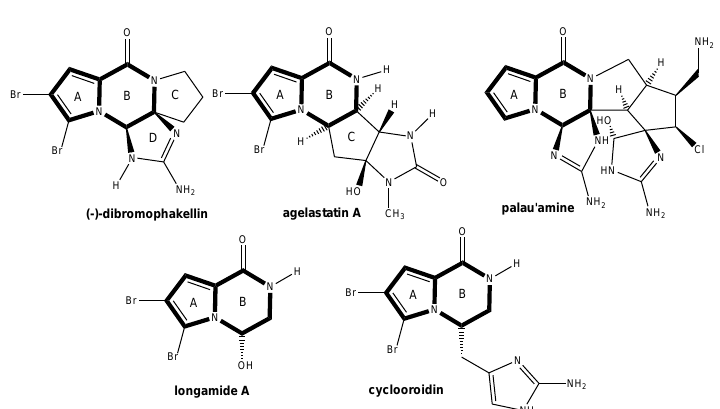
Figure 1. Example of pyrrole-imidazole compounds having a pyrrolopyrazinone bicyclic system (Jacquot et al ., 2004).